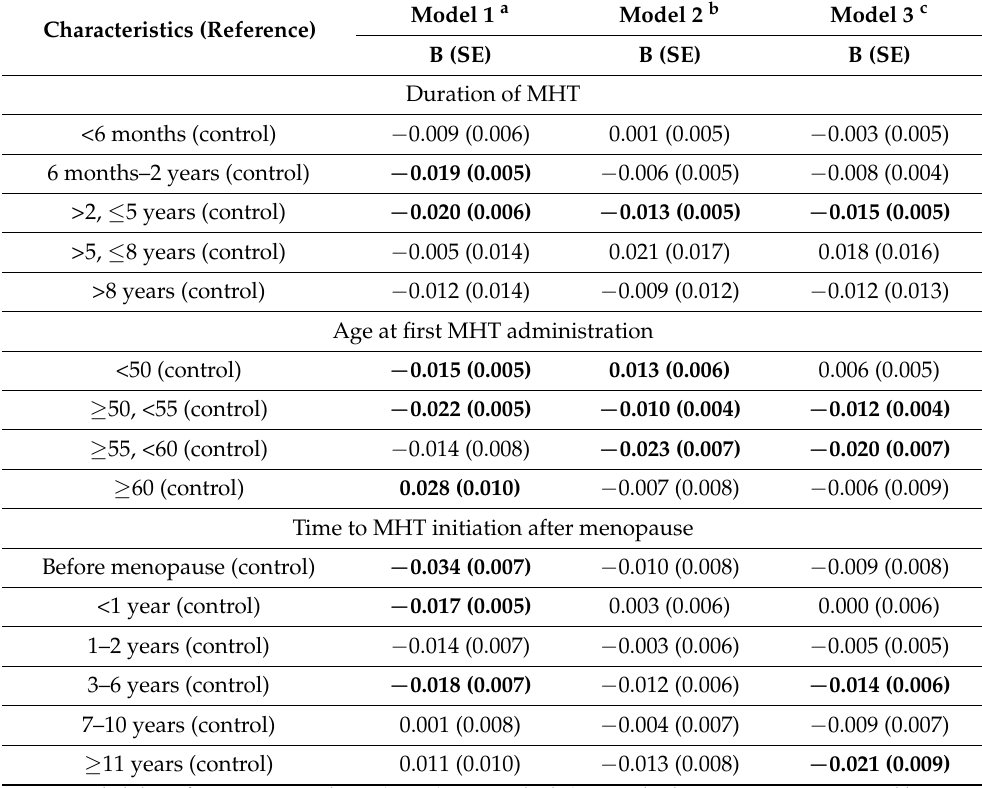
Table 5. Associations between MHT-related information and frailty (IPTW regression analysis).